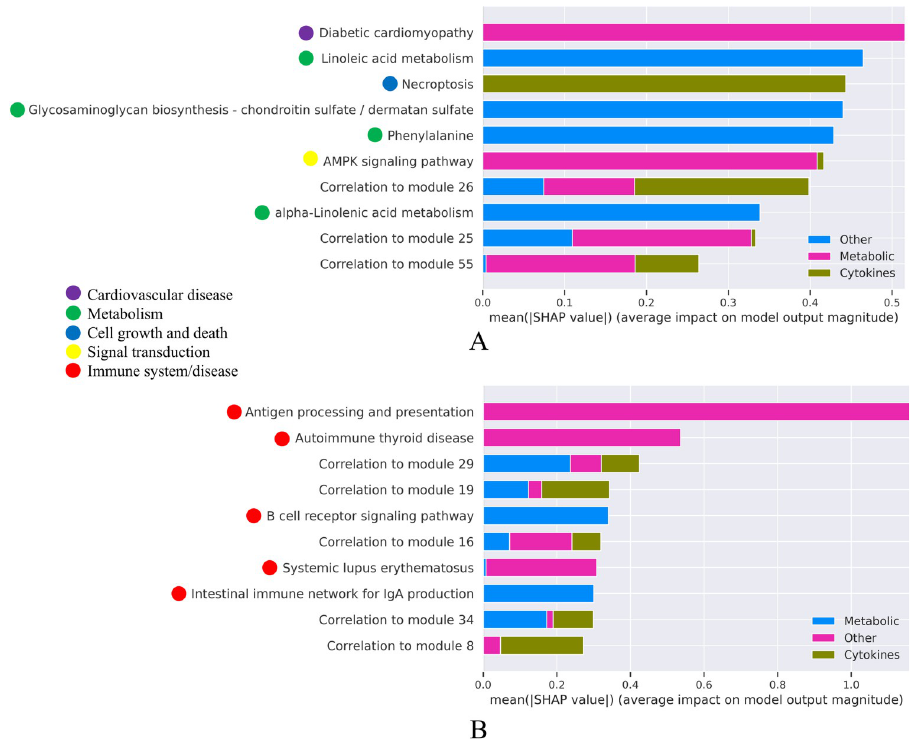
Fig 3. Top 10 features (pathways) and their average SHAP influence (absolute values) on the magnitude of the model prediction. A. Calculated for subcutaneous adipose. B. Calculated for visceral adipose. The SHAP method illustrates the magnitude of the effect of each feature (KEGG pathway) on each classification. The colored dots to the left highlight KEGG’s BRITE annotations of the